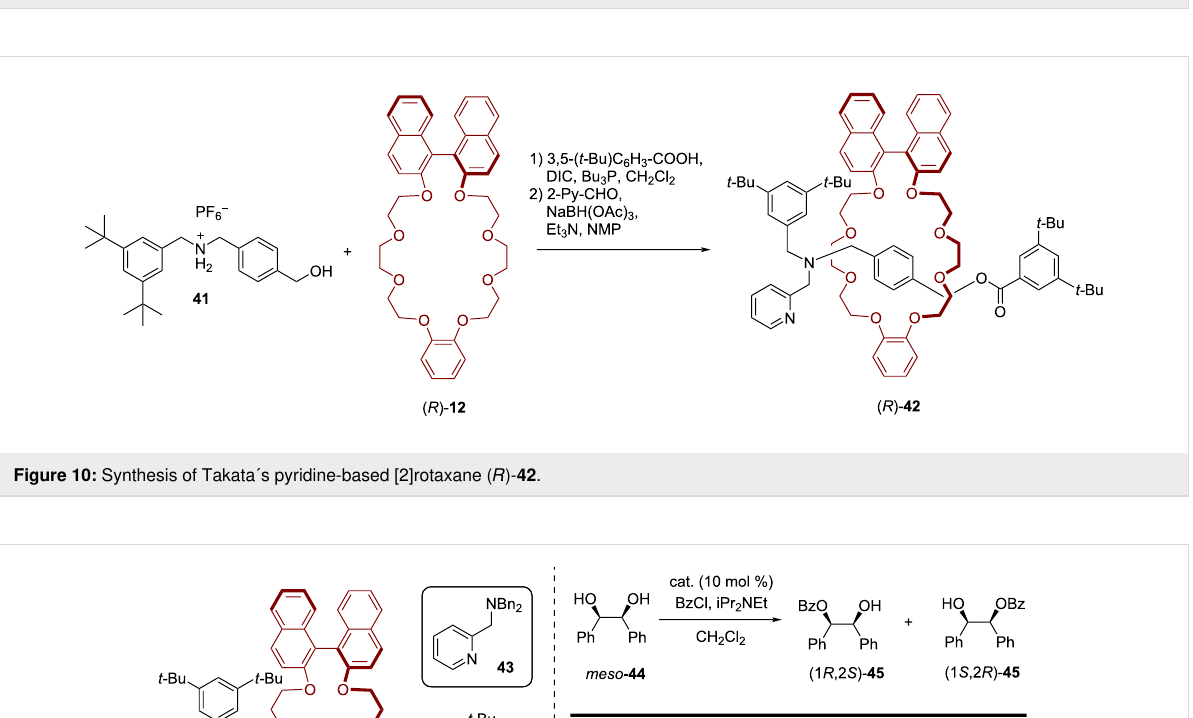
Figure 9: Results for the asymmetric benzoin condensation of benzaldehyde ( 39 ) with catalysts ( R )- 35a / b and ( R )- 38 .